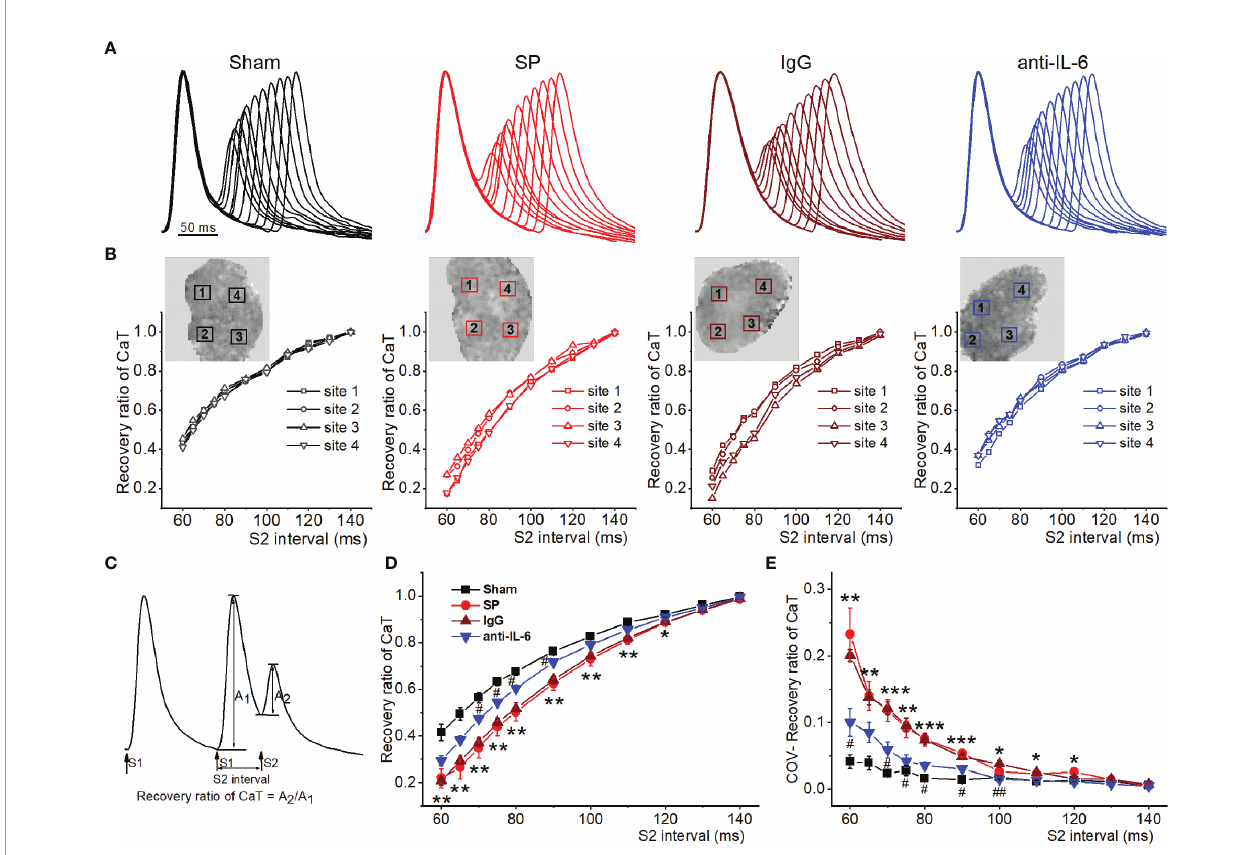
FIGURE 6 | IL-6 neutralization improves atrial RyR refractoriness in SP rats. (A) Superimposed CaT traces from the 4 indicated groups at S2 intervals ranging from 140 to 60 ms. (B) The recovery ratio of CaT (A 2 /A 1 ) was plotted against the S2 interval at the 4 locations indicated with a box in the upper map from the 4 groups. (C) Calculation diagram of recovery ratio of CaT. (D, E) Quanti fi cation of recovery ratio of CaT (D) and its COV (E) . n = 6/group. *P < 0.05, **P < 0.01, ***P < 0.001 vs . Sham; # P < 0.05, ## P < 0.01 vs . IgG, determined by Student t-test or one-way ANOVA with Bonferroni ’ s post-hoc